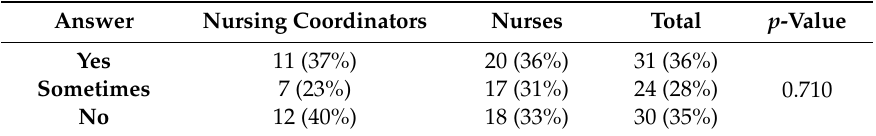
Table 3. Frequency distributions (values and row percentages) and p -values (Yates’s chi-squared test) of the answers to the question “In your clinical practice, do you recommend vaccinations to your